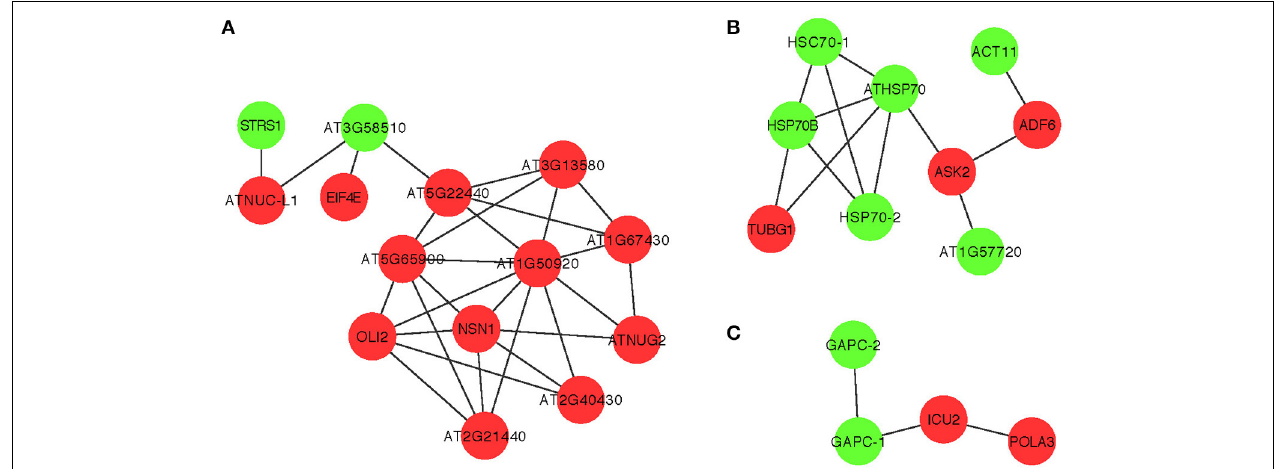
FIGURE 6 | Physical and genetic protein interaction networks of predicted orthologous cell-intrinsic restriction factors and pro-viral host factors in plants. Functions of the Arabidopsis genes are listed in Table 1 . Red nodes indicate inhibitory CIRFs, while green nodes show positive proviral host factors. (A–C) The three major groups of molecular networks with predicted orthologous CIRFs of Arabidopsis . These three small networks were generated with Arabidopsis thaliana orthologs to represent